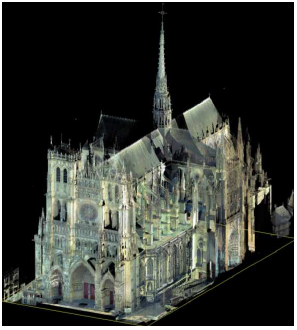
Figure 1: View of the Amiens cathedral point clouds model